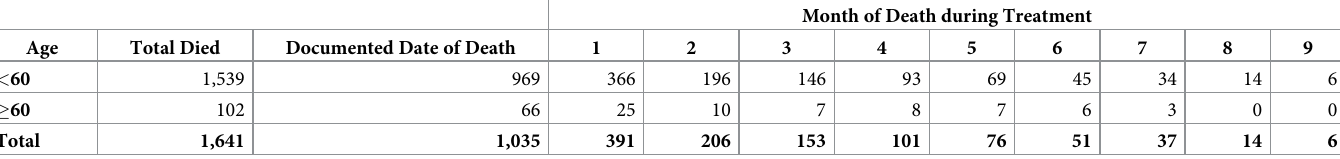
Table 4. Comparison of treatment outcomes between elderly and non-elderly TB patients. Variable < 60 n (%) Treatment success